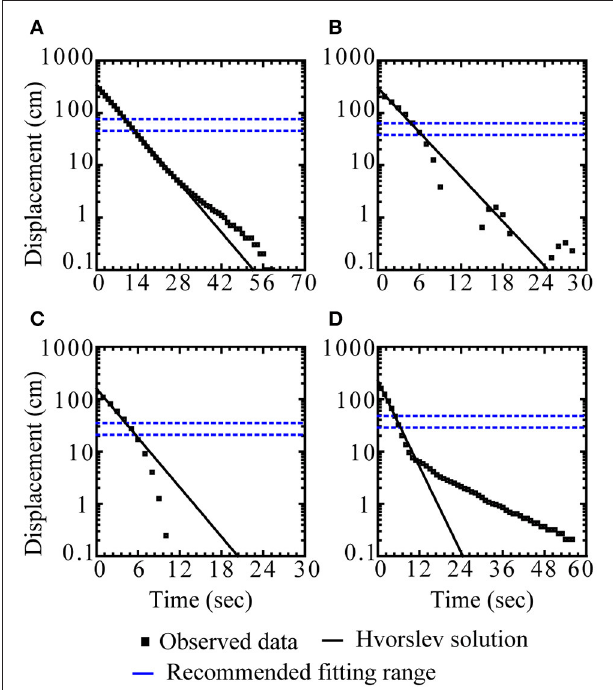
FIGURE 4 | Slug test curve fitting. Water level responses over time (squares), Hvorslev solution (lines) for representative slug tests, and recommended fitting range (blue dashed lines). Water levels generally match the predicted recovery (A) , recover rapidly, and sometimes oscillate slightly (B) , recover more quickly than predicted (C) , or recover more slowly than predicted (D)